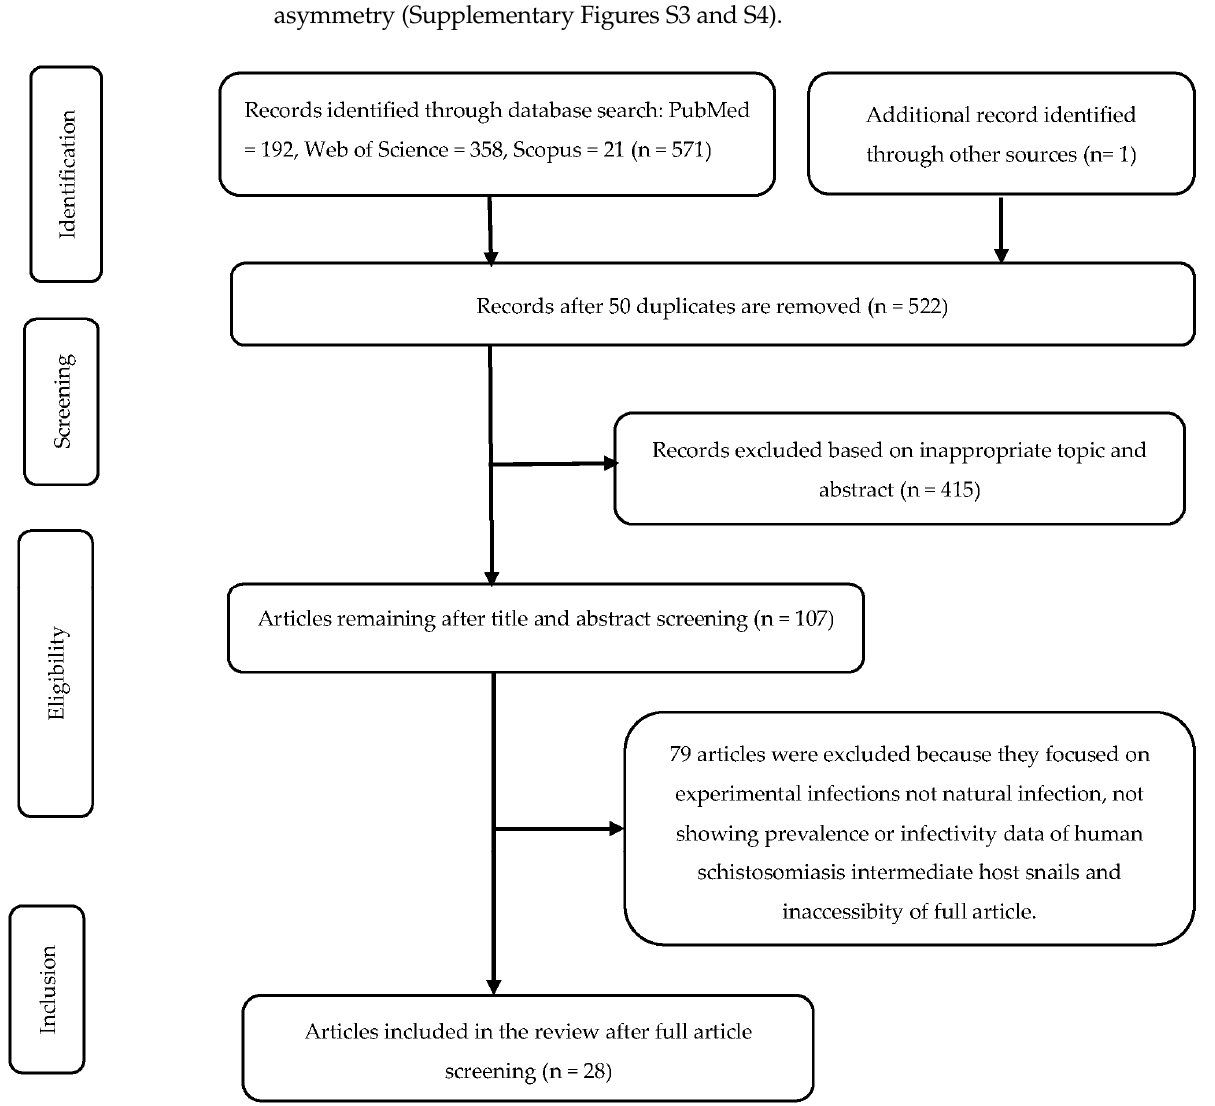
Figure 1. PRISMA flow diagram of the studies included in the meta-analysis.